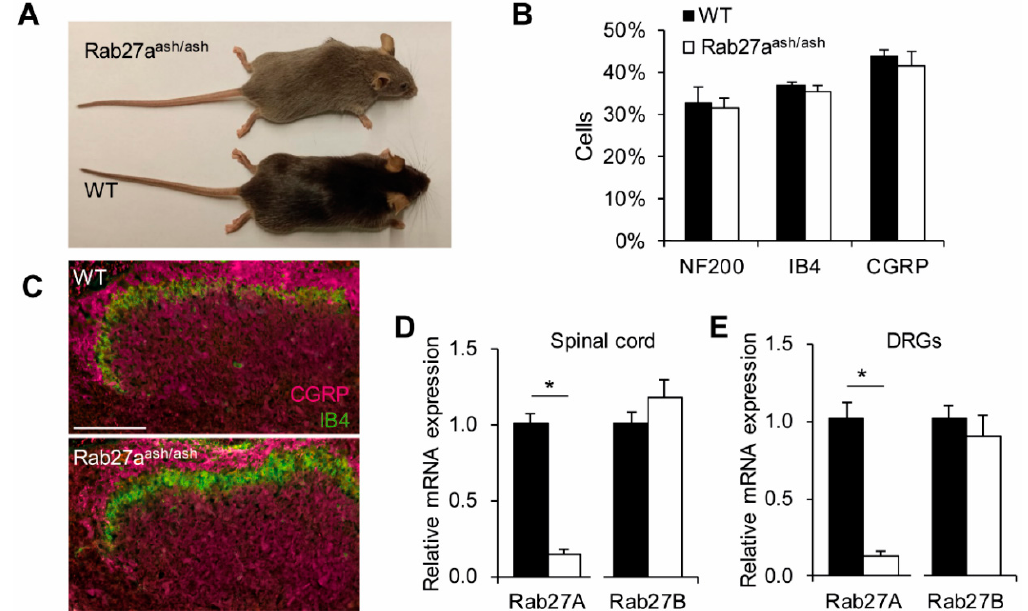
Figure 4. Basal characterization of Rab27a ash / ash mice. ( A ) Rab27a ash / ash mice exhibit a gray coat color. ( B ) Quantification of DRG neuron populations in Rab27a ash / ash and WT mice. The percentage of NF200, isolectin-B4 (IB4) and CGRP-positive DRG neurons is similar between genotypes ( n = 3). ( C ) Distribution of primary a ff erent terminals as assessed by the markers CGRP and isolectin-B4 (IB4) is comparable between genotypes; Scale bar: 100 µ m. ( D–E ) The isoform Rab27b is not compensatory upregulated in Rab27a mutant mice in the spinal cord ( D ) or in DRGs ( E ); * p < 0.05.